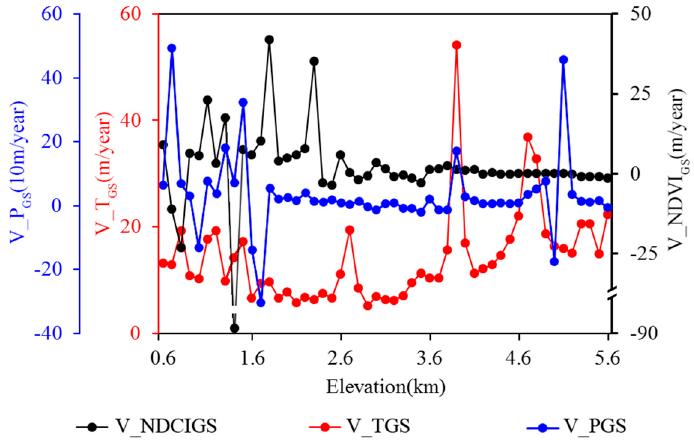
Figure 3. Dependence upon elevation of the elevational variation rate of NDVI GS isoline (V_NDVI GS , black solid line), T GS isoline (V_T GS , red solid line), and P GS isoline (V_P GS , blue solid line) plotted against elevation.